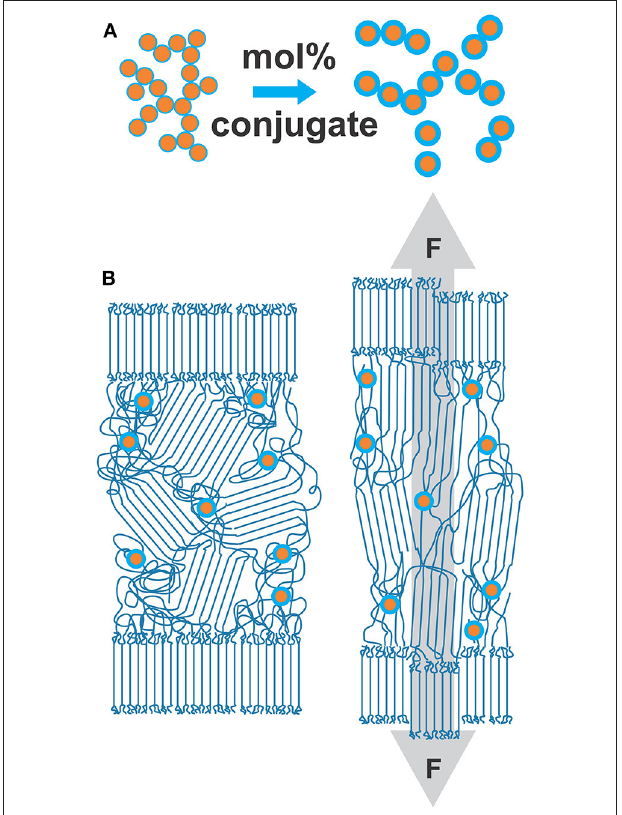
FIGURE 7 | Schematic representation of the hybrid material at the nanometer scale. (A) Increasing amount of conjugate leads to higher layer thickness and reduces agglomeration (less branched aggregates) as derived from the fractal dimension D. (B) Deformation mechanisms of PEO + 15 wt.% conjugated MgF 2 during applied tensile stress. The use of conjugate led to a stabilization of the amorphous phase. The stabilization of MgF 2 nanoparticles by the peptide-PEG conjugate blocked the movement of dislocations within the amorphous phase. The amorphous PEO chains cannot elongate as in non-filled PEO and the force transmission from the amorphous to the crystalline phase appears earlier resulting in a faster block-slip mechanisms and therefore, decreasing crystallite